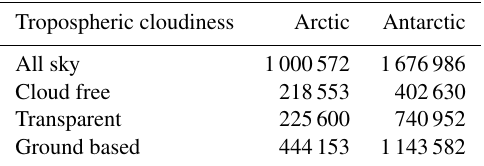
Table 2. Number of considered CALIPSO profiles with PSC obser- vations for different tropospheric cloudiness in the Arctic (Decem- ber 2006 to February 2018) and the Antarctic (winters of 2012 and 2015). The sum of cloud-free conditions and profiles with transpar- ent clouds makes up the view of a ground-based